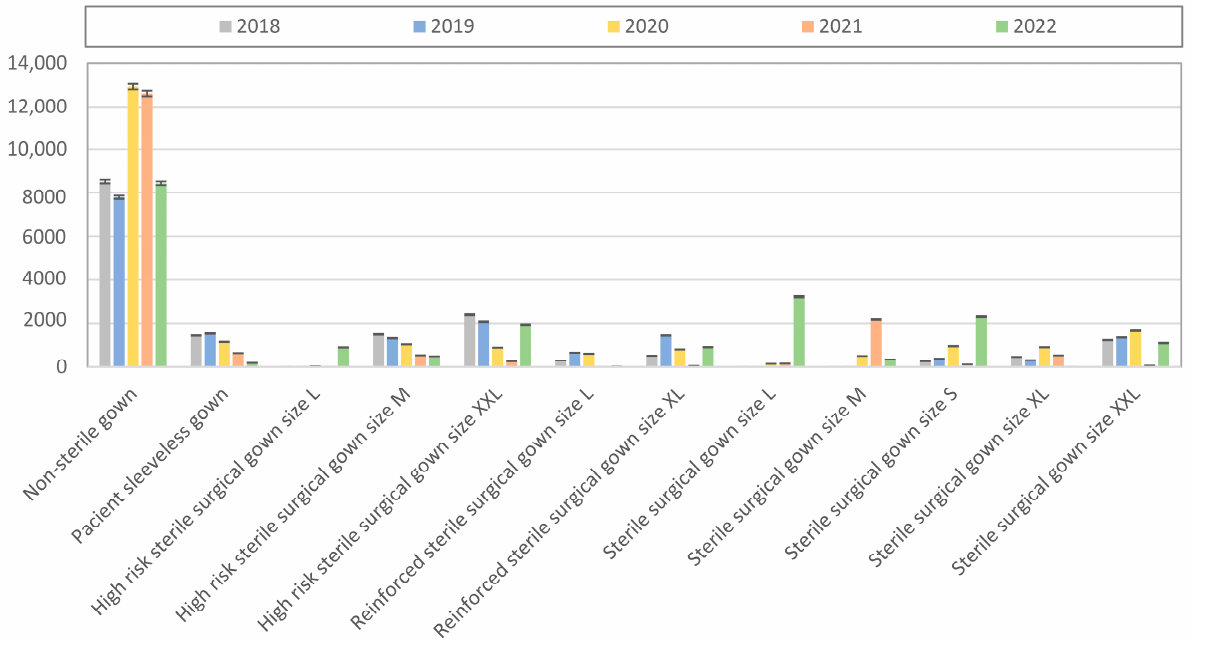
Figure 3. Annual carbon footprint of the total gown consumption. 3.1. Preliminary Analysis of the Potential Benefits Associated with the Implementation of a Circularity Model The results obtained in the previous categories indicate that the non-sterile gown had the highest environmental footprint, especially concerning the carbon footprint. This par- ticular gown presented some characteristics that facilitated the design and implementa- tion of a circular economy model. Due to the simplicity of its composition, recycling this gown does not require any kind of separation. That reduces the operational costs that manual separation would entail. Additionally, contrary to the more protective gowns, the non-sterile gown is never used in situations with the presence of infectious agents. This reduces the risk of contamination through the remanufacturing process. An outline of the potential circular economy model is depicted in Figure 4. After be- ing used, the gowns would be collected and transported to a recycling plant. The used